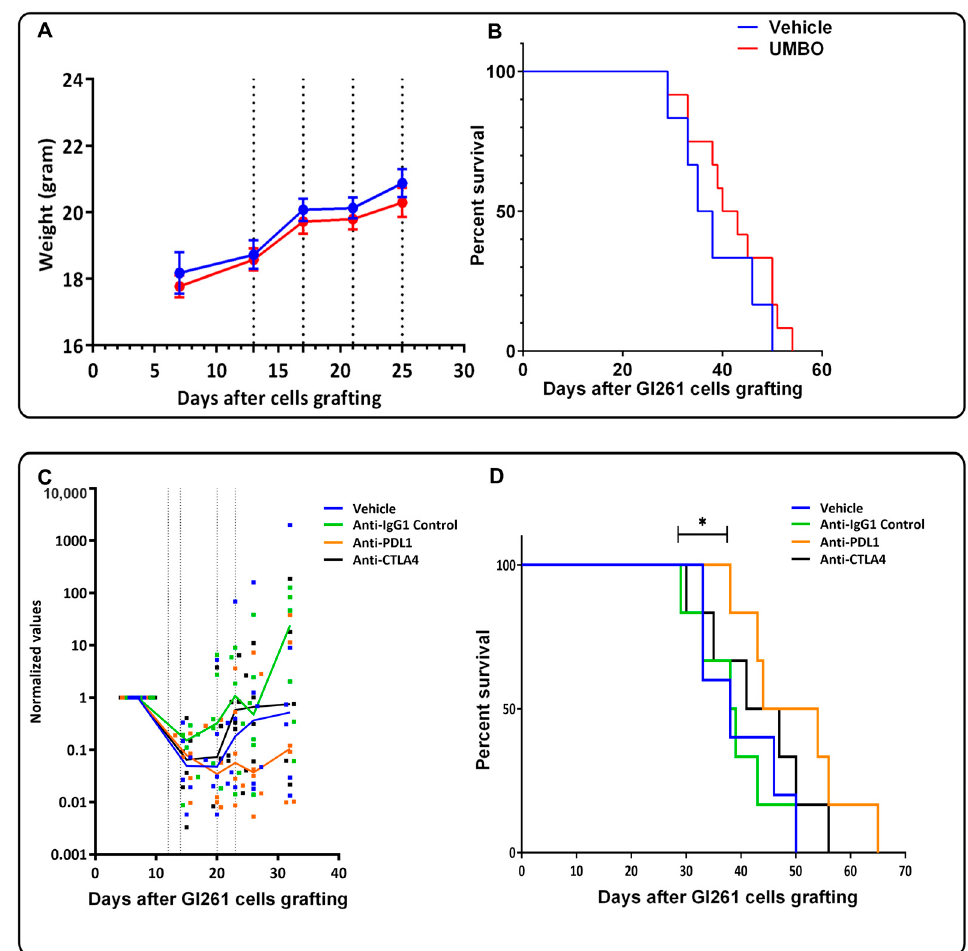
Figure 2. UMBO parameters are safe and anti-PD-L1 increased survival of GL261 bearing mice. Repeated UMBO alone does not affect OS (Panel B ) or body weight in GL261-bearing mice compared to the non-treated (Panel A ). (Panel C , D ): Animals were treated with 200 µg of anti-PDL-1, Anti-IgG1 as (a control), anti-CTL-4, or vehicle for four doses. Bioluminescence measures normalized to the first measured value performed on day 7 after cell inoculation in GL261-bearing mice model. Each colored dot represents values for one animal and the line represents the median value for the group. Bioluminescence signal was measured weekly. Dotted lines represent the days of treatments.